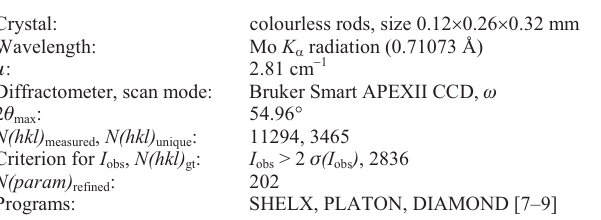
Table 1. Data collection and handling.